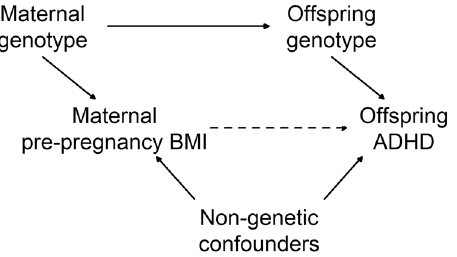
Fig. 1 Directed acyclic graph of potential relations between maternal BMI and offspring ADHD. The dashed line represents the effect of interest and solid lines represent other hypothesised associations.